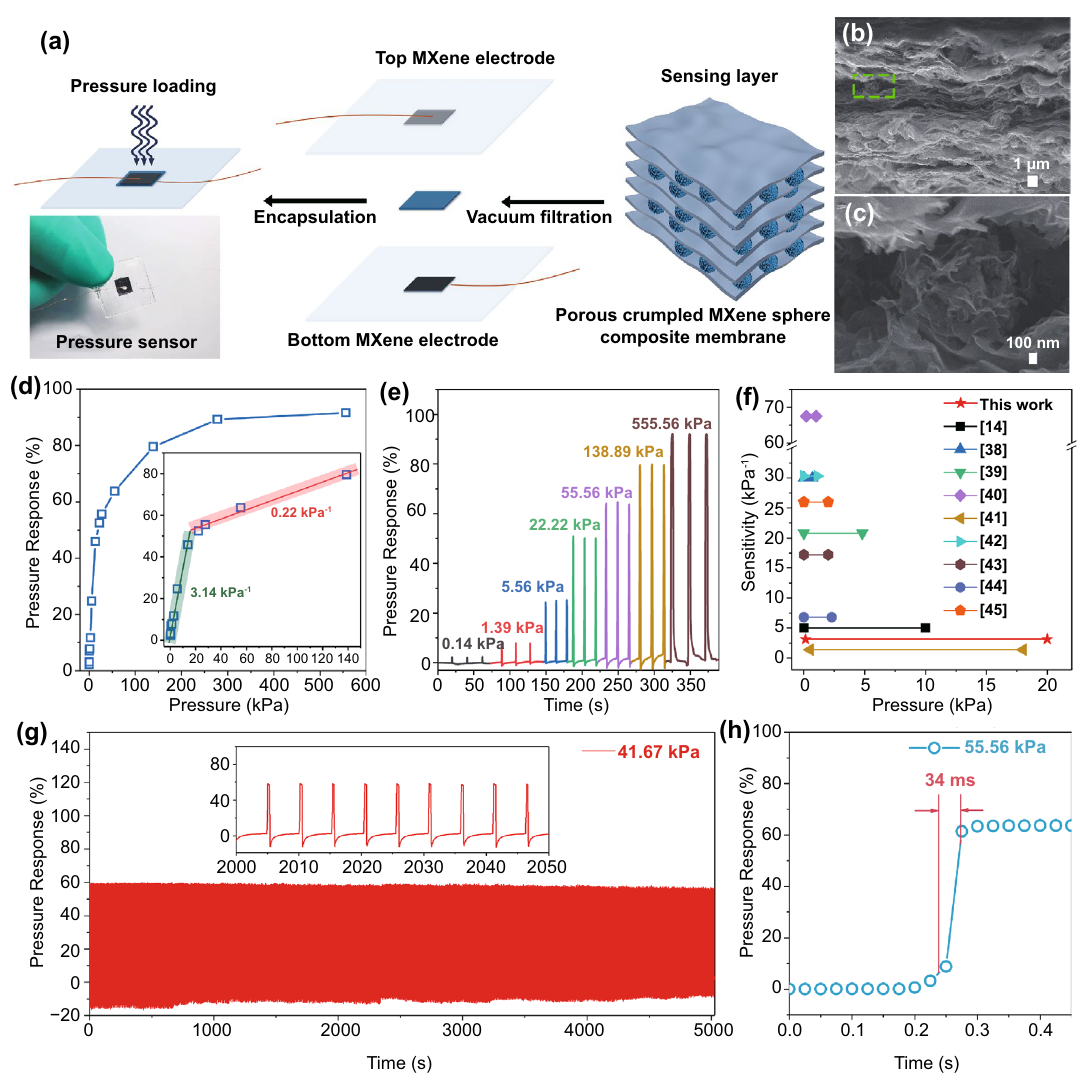
Fig. 4 a Schematic diagram of the pressure sensor fabrication based on MS-2-10 and a photograph of the fabricated pressure sensor. b The cross section SEM image of the composite membrane and c the close-up image of porous crumpled MXene sphere in the green box. d Pressure response value curve and sensitivity with pressure, inset shows the linear range of pressure response curve. e Real-time resistance curve at dif- ferent pressures. f The performance comparison of resistive pressure sensors based on MXene and graphene. g Real-time resistance curve of 41.67 kPa pressure load with 1000 recycles, inset shows the enlarged curve from 2000 to 2050s. h Pressure response time at a loading pressure of 55.56